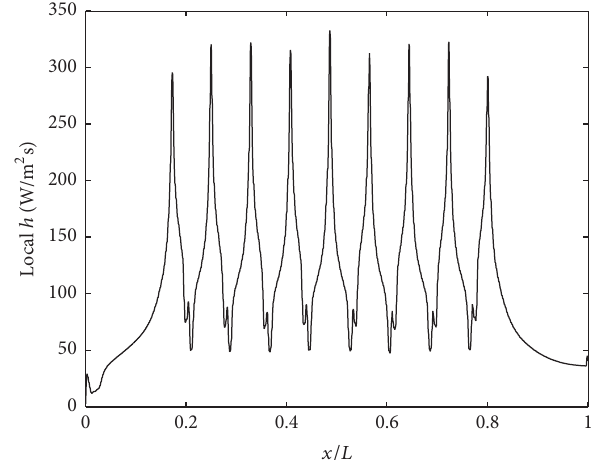
Figure 4: Local ℎ at 1000 positions along the sheet as a function of normalized distance 𝑥/𝐿 from the sheet entrance